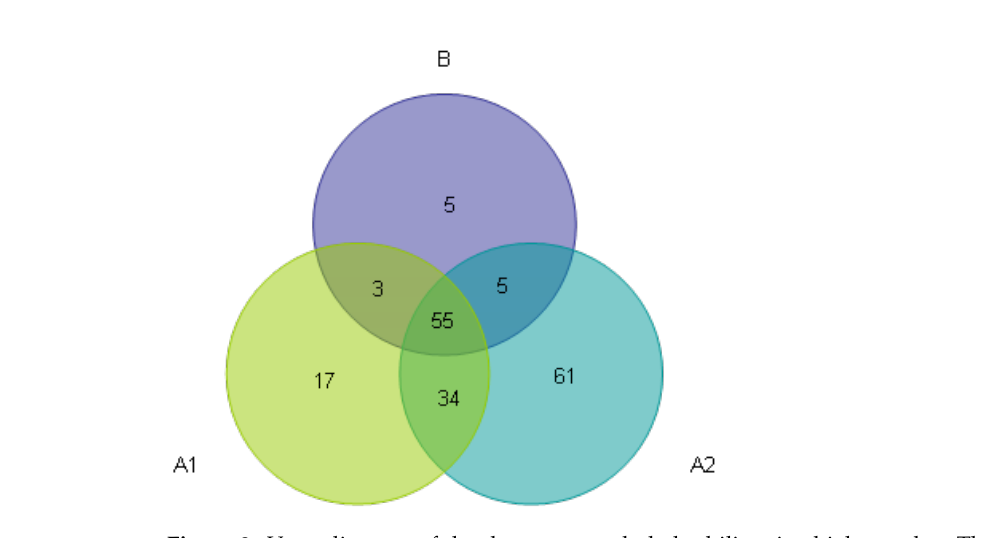
Figure 3. Venn diagram of the three extremely halophilic microbial samples. The number of the OTUs is shown inside the diagram. A total of 17, 5 and 61 unique OTUs were found in A1, B and A2, respectively, and 55 OTUs were shared among the three samples.